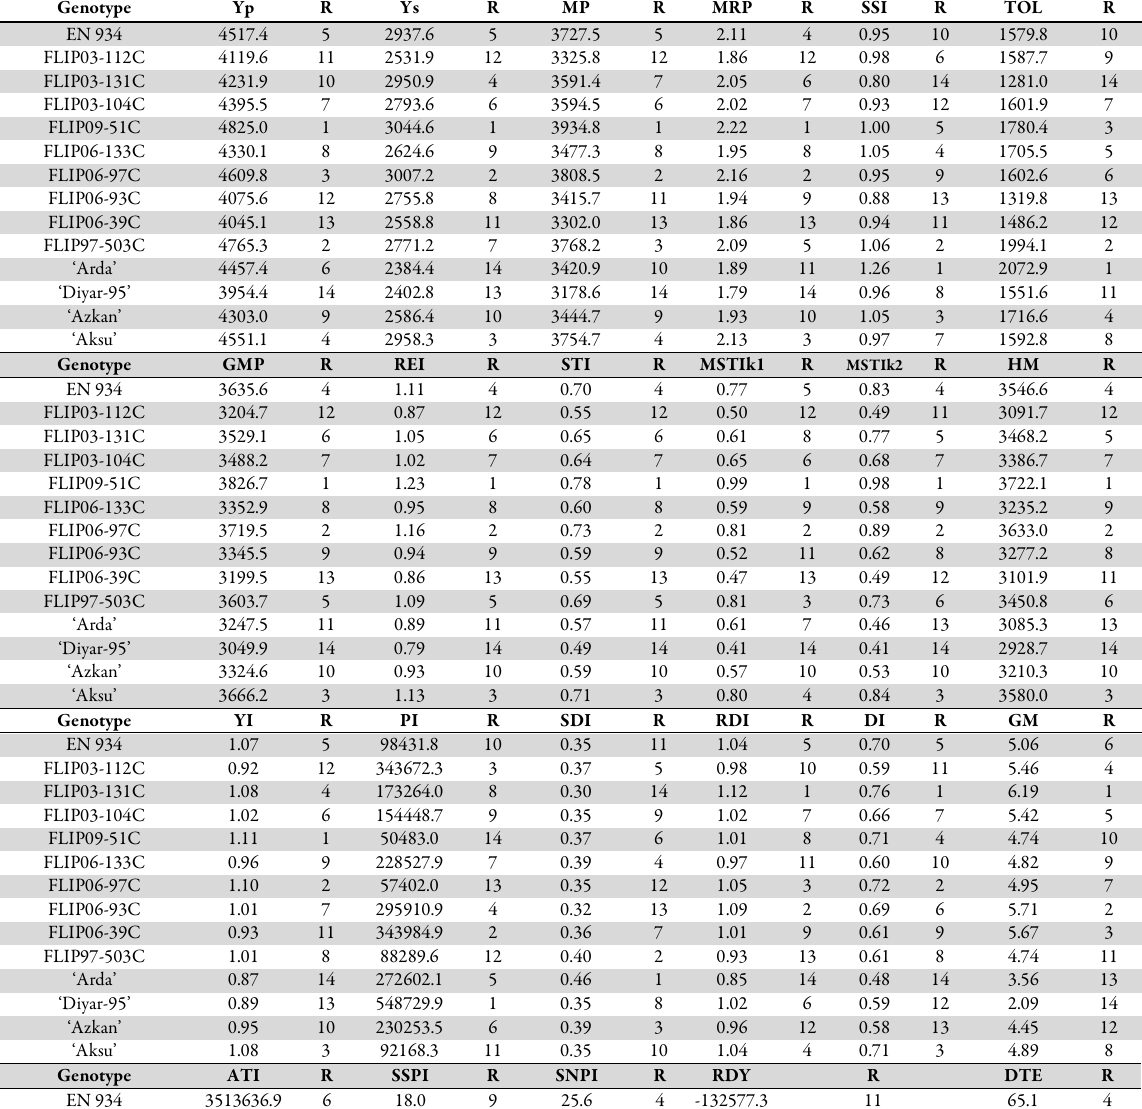
Table 3. Mean comparison for yield performances of chickpea genotypes in non-stressed and stressed conditions and twenty-three drought resistance indices Genotype